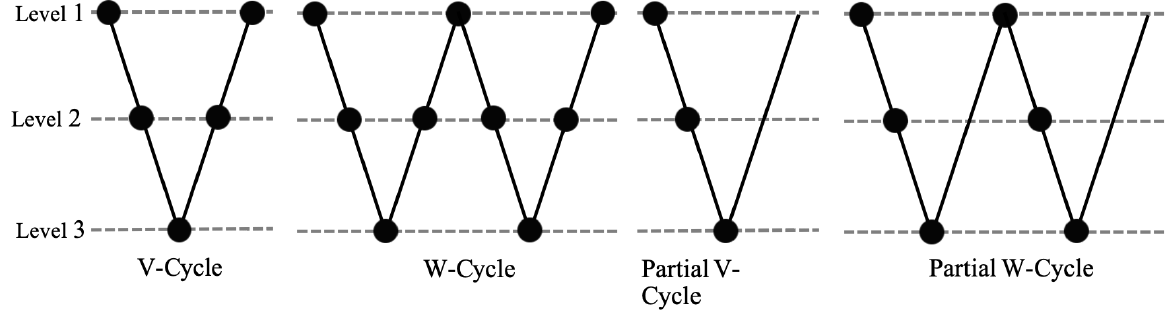
Figure 2. Multigrid Cycles for three